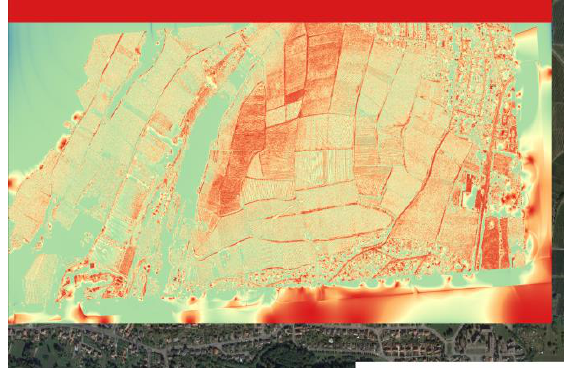
Figure 11. The very important calculation then was the